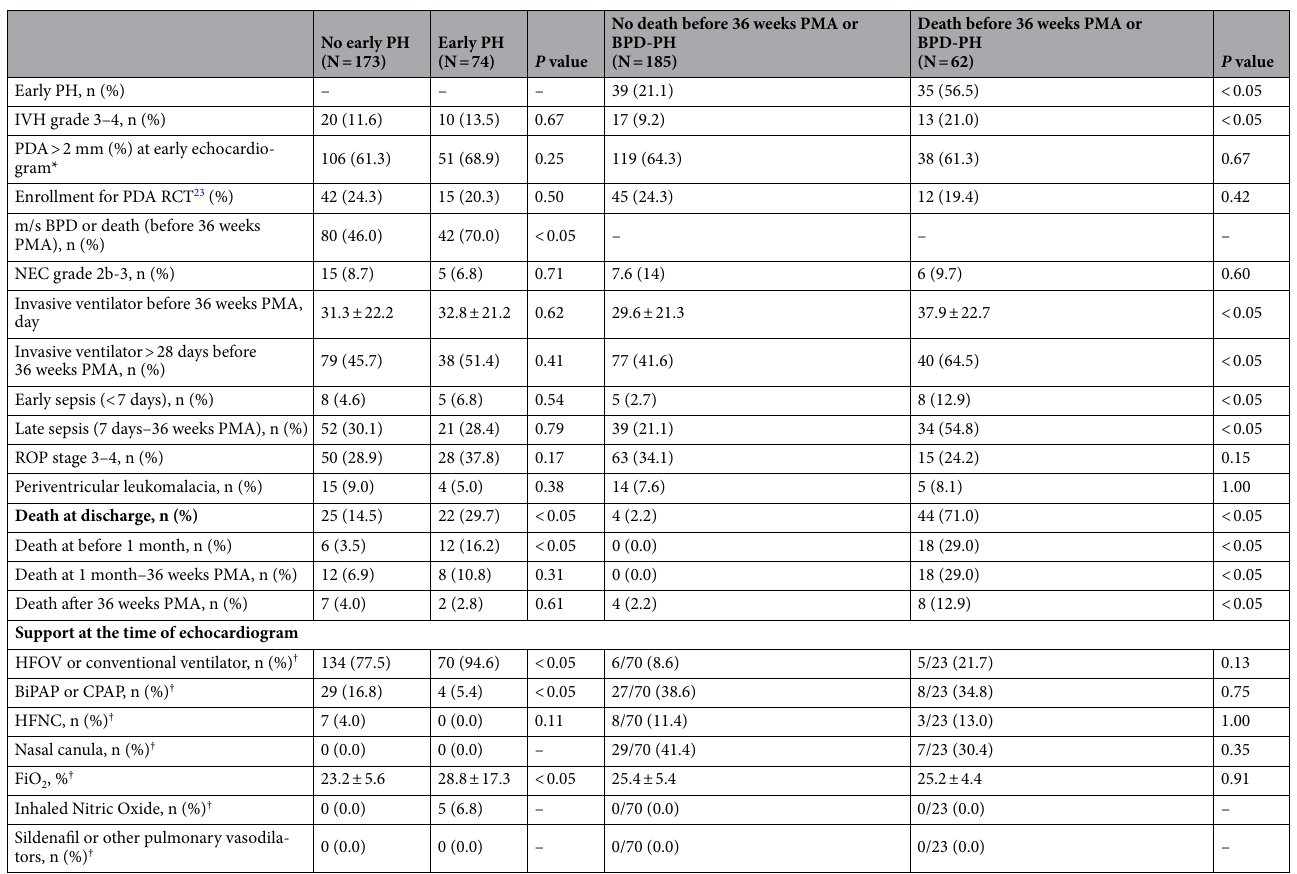
Table 2. Neonatal morbidities and mortality. *PDA was managed using conventional nonintervention treatment (not to treat) with careful fluid management based on our unit policy 22 . † Calculated only for infants with an early or late echocardiogram, PH pulmonary hypertension, m/s BPD moderate to severe bronchopulmonary dysplasia, BPD-PH m/s BPD associated late PH, IVH intraventricular hemorrhage, RCT randomized clinical study, NEC necrotizing enterocolitis, PMA post-menstrual age, ROP retinopathy of premature, HFOV high frequency oscillatory ventilation, BiPAP bilevel positive airway pressure,